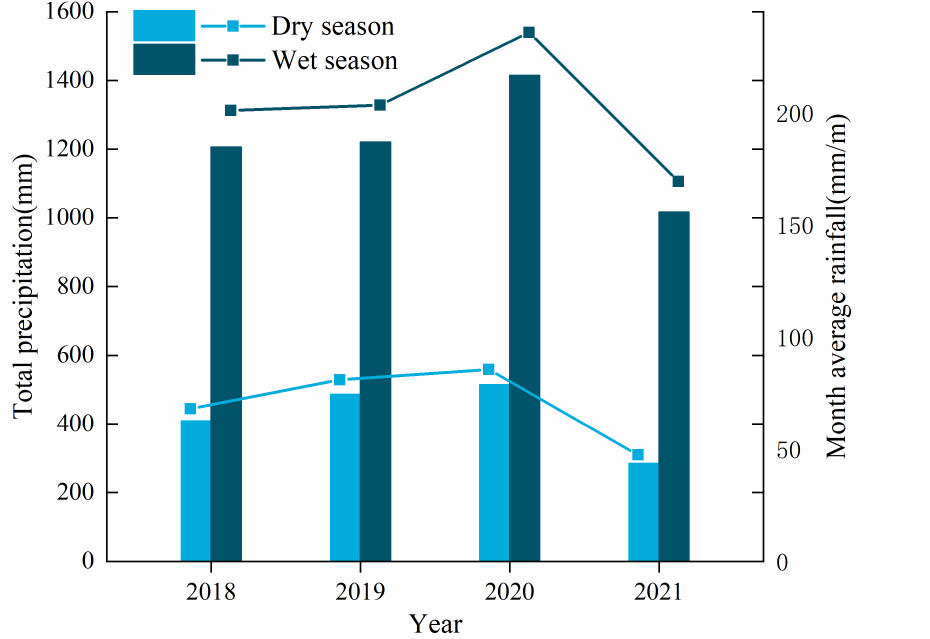
Figure 15. Seasonal precipitation. Wet season: from May to October. Dry season: from January to April, November, and